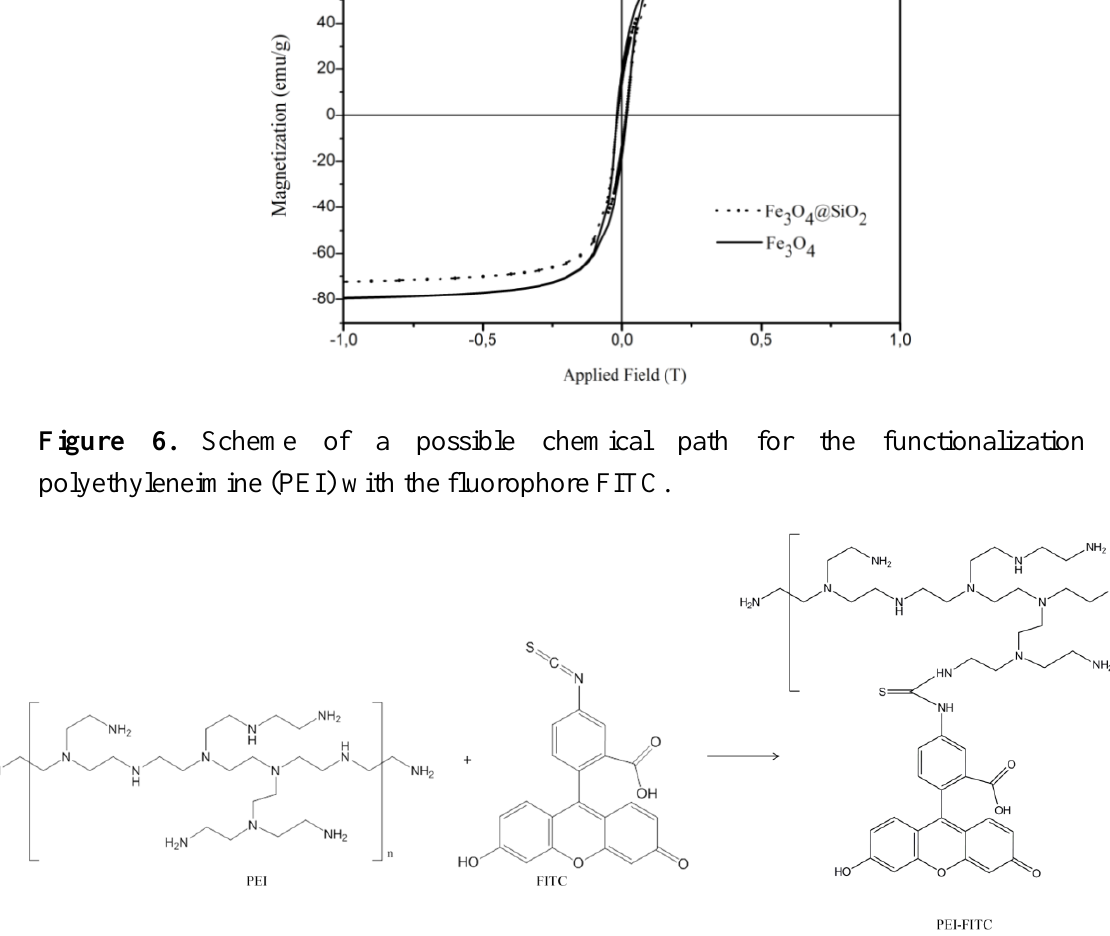
O and Fe O @SiO as a function of the magnetic field 3 4 3 4 2